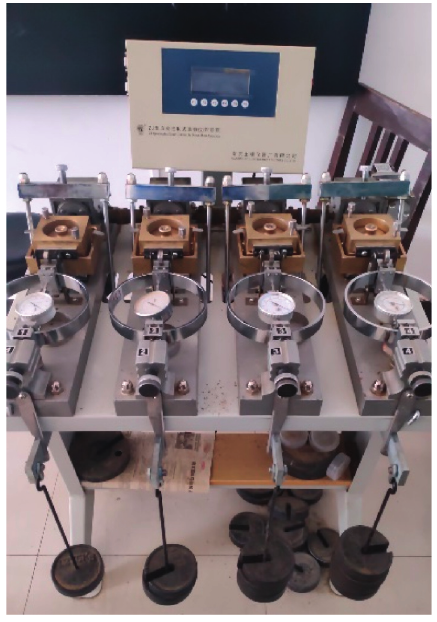
Figure 10: Electric quadruple direct shear apparatus.